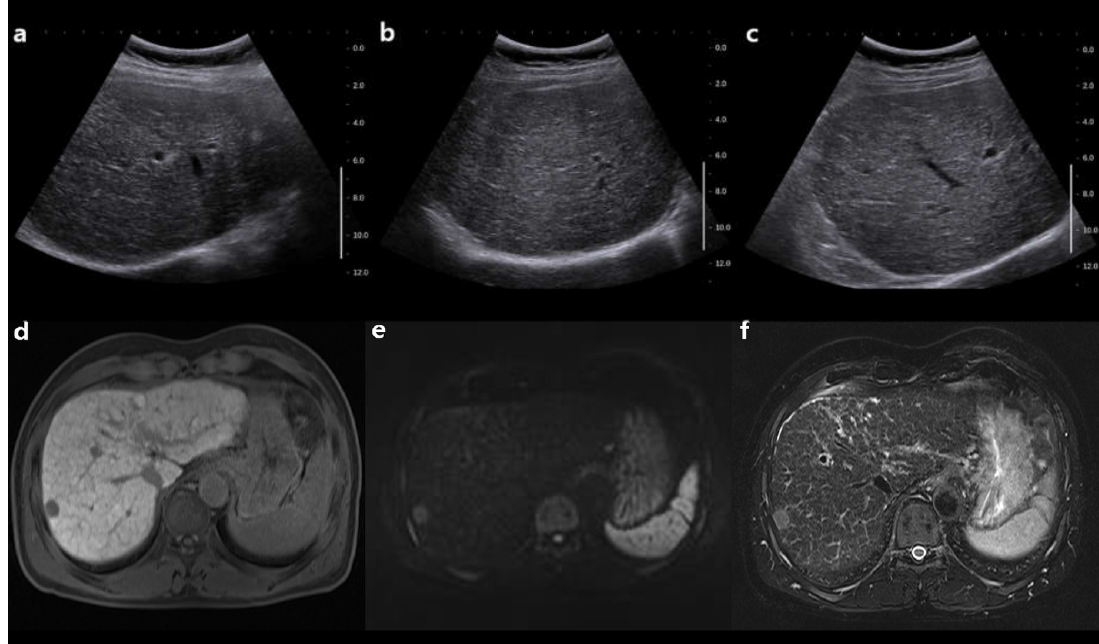
Figure 3. A 64-year-old man with chronic hepatitis B. ( a – c ) Surveillance ultrasonography does not show any focal hepatic lesion, whereas ( d – f ) surveillance AMRI shows a 1.5 cm nodule in segment VII. Ultrasonography shows coarse echotexture of the liver (a) , but it shows no focal hepatic lesion on the right lobe upper view (b) and lower view (c) . The nodule has hypointensity on the hepatobiliary phase image ( d ), restriction on the diffusion-weighted image ( e ), and moderate hyperintensity on the T2-weighted image ( f ). The surveillance AMRI enabled us to make a diagnosis of HCC.